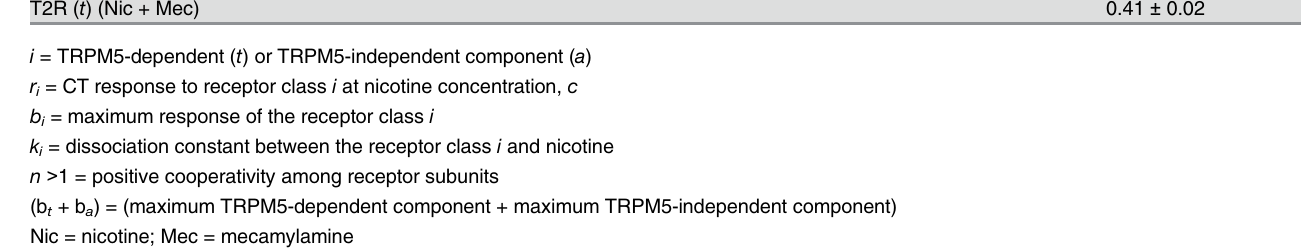
Here i has either the value t for the T2R component or a for the nAChR component. r i is the CT response to receptor class i at nicotine concentration, c , b i is the maximum response of the receptor class i , k i is the dissociation constant between the receptor class i and nicotine, and n values greater than one indicate positive cooperativity among receptor subunits. Table 1 gives the nonlinear regression fi t parameter values for each receptor type in the absence and presence of Mec in the nicotine stimulus solutions. Table 1. Least squares fit parameter values for TRPM5-dependent and TRPM5-independent components of the nicotine CT response. Receptor type (Stimulus) b